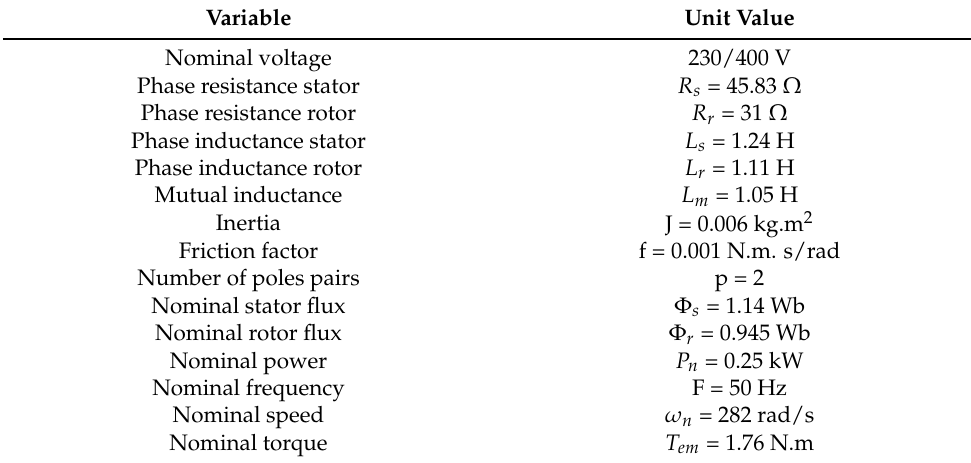
Table A1. Parameters of the induction